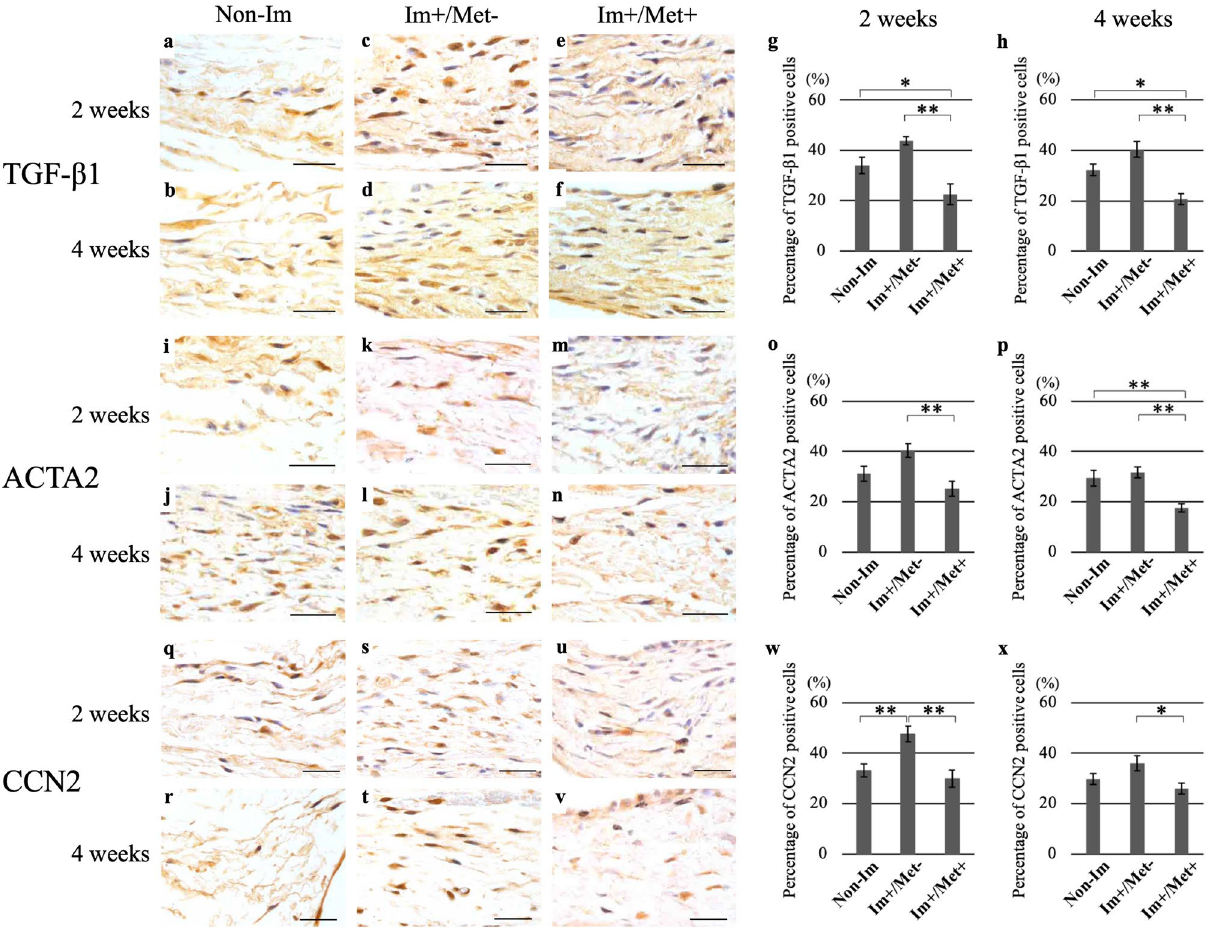
Figure 4. Immunohistochemical analysis for the effect of metformin on joint capsular fibrosis. Immunohistochemical staining for TGF-β1, ACTA2, and CCN2 in the posterior capsule. Microscopic images of specimens immunostained for TGF-β1 ( a – f ), ACTA2 ( i – n ), and CCN2 ( q – v ) with DAB, and counterstained with hematoxylin (Scale bar: 50 μm). Percentage of TGF-β1-positive cells ( g , h ), ACTA2-positive cells ( o , p ), and CCN2-positive cells ( w , x ) to the total number of cells in the posterior joint capsule at 2 and 4 weeks, respectively. Data are expressed as the mean ± standard errors. *p < 0.05, **p < 0.01; n = 5. TGF-β1 transforming growth factor beta 1, ACTA2 actin alpha 2, CCN2 cellular communication network factor 2, Non-Im mice with non-immobilized knees, Im+/Met− mice with immobilized knees but no metformin, Im+/Met+ mice with immobilized knees who were administered metformin, DAB 3,3 ′